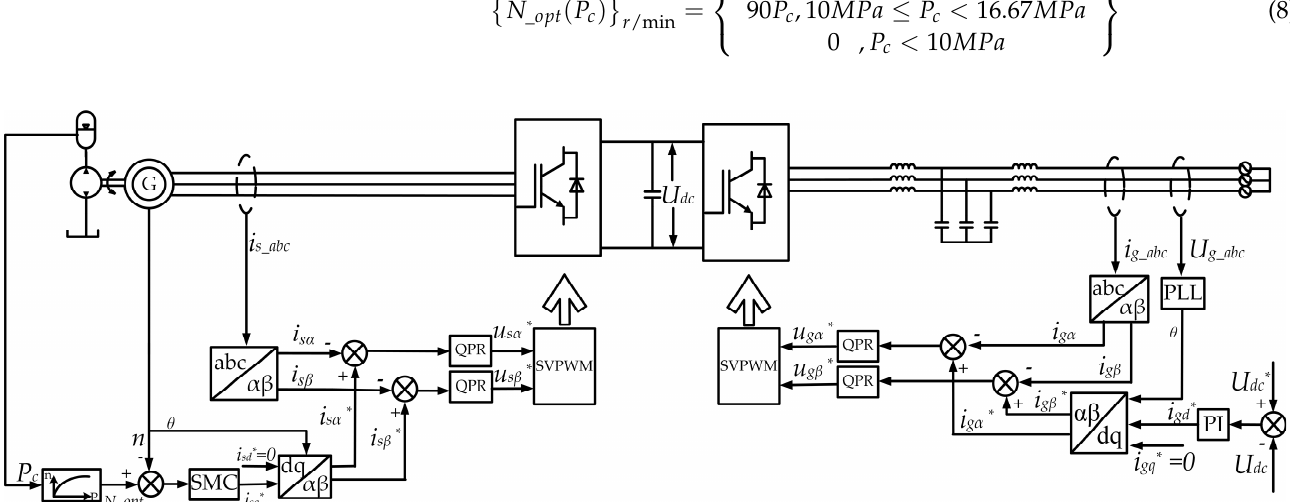
Figure 2. Control block diagram of hydraulic storage wave power ‐ generation system.